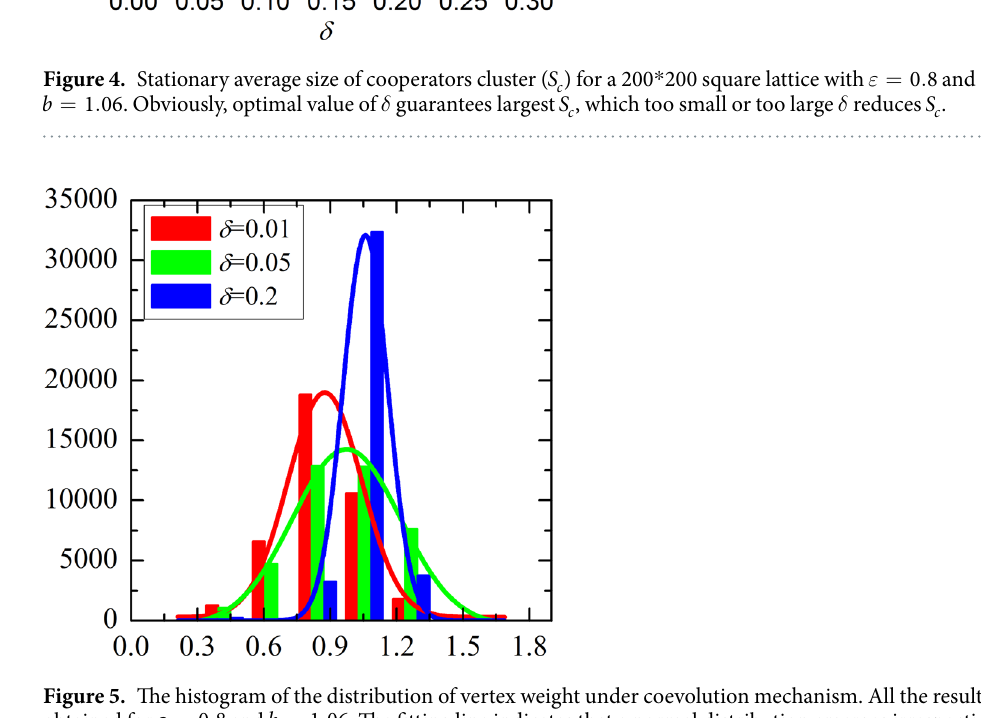
Figure 5. The histogram of the distribution of vertex weight under coevolution mechanism. All the results are obtained for ε = . 0 8 and = . b 1 06 . The fitting line indicates that a normal distribution emerges irrespective of which δ applies, and the ranking of the variance of three cases is